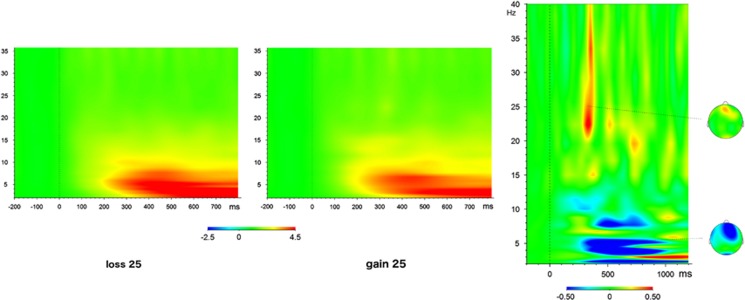
Time-frequency plot and scalp topographies for theta (5.1 Hz) and high-beta (25.5 Hz) oscillatory responses to gain vs loss feedback (time point 0) in the high-magnitude condition (right) and in each condition separately (left). Normed values with respect to a 200 ms pre-stimulus baseline are depicted.